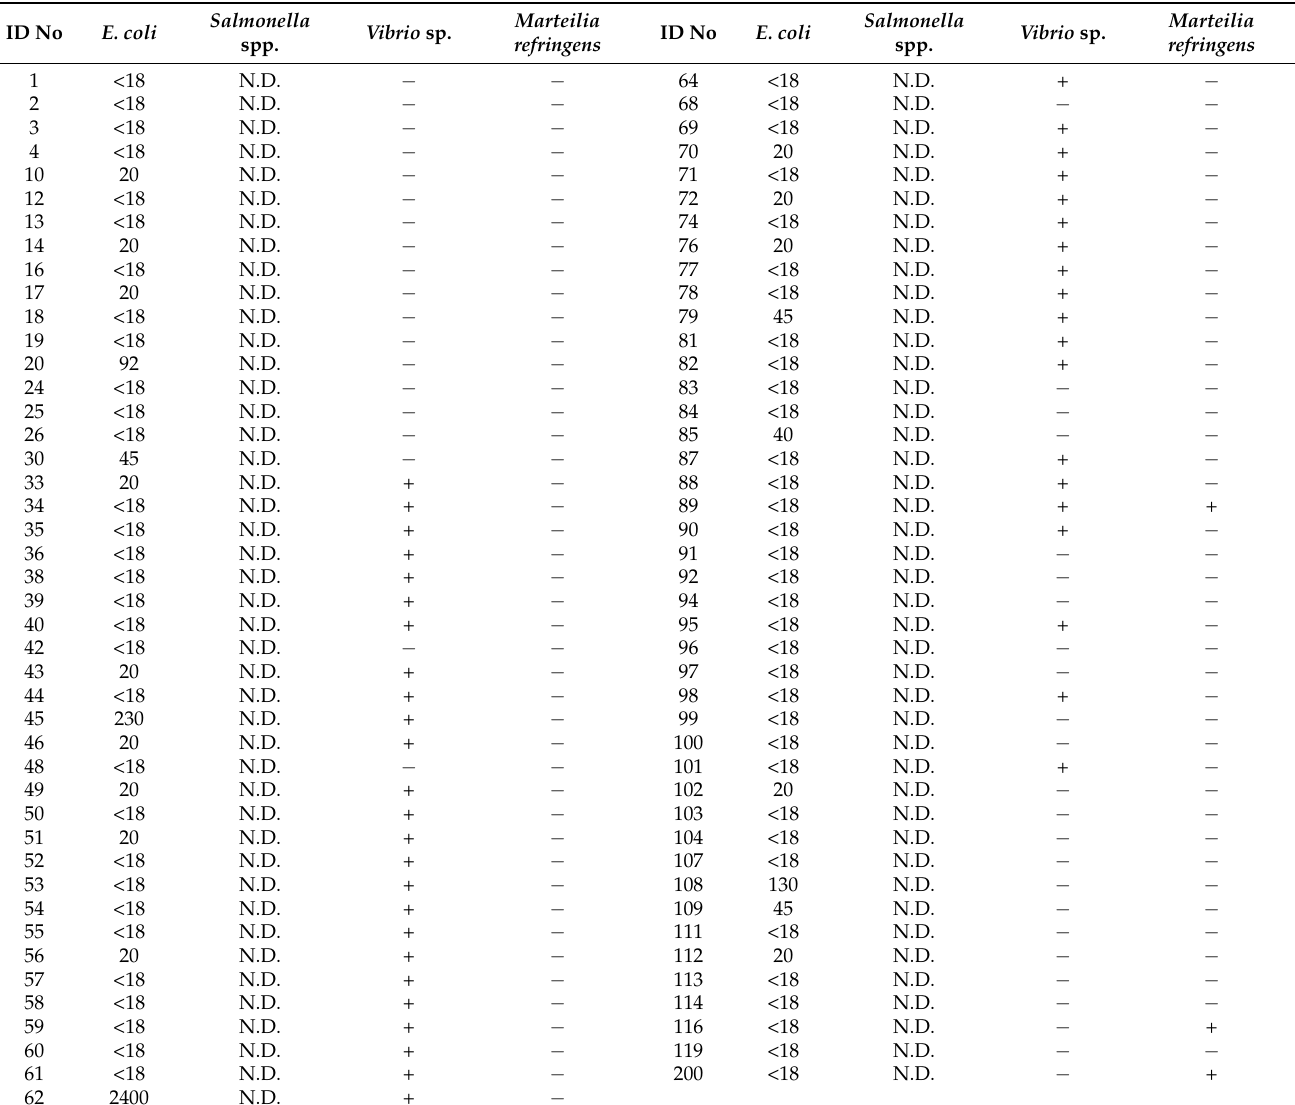
Table 2. Detected microorganism in each analyzed bivalve. ID code according to Table 1. N.D. corresponds to “not detected”; “ − ” corresponds to absence of target microorganism; “+” corresponds to presence of target microorganism; E. coli is expressed in cfu/100 g. Salmonella Vibrio ID No E. coli spp.